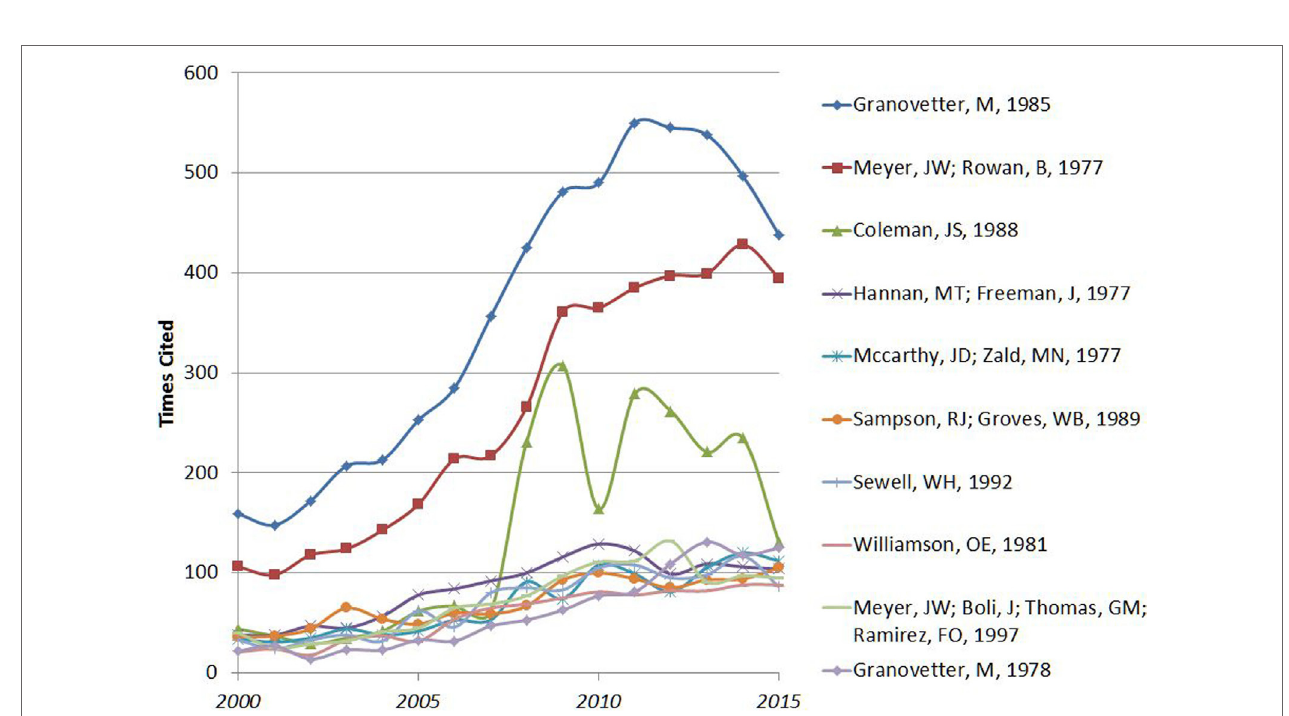
FigUre 3 | Ten most-cited papers in AJS (14 February 2016)